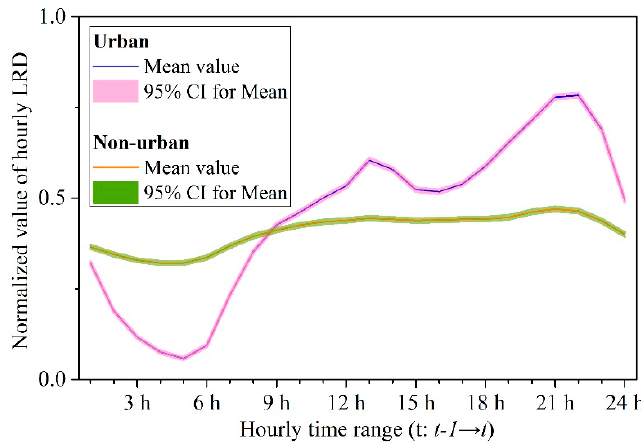
Figure 3. The normalized value of hourly LRD for urban and non-urban samples during the research period. Table 2. The six RS and nine GIS potential features for the random forest classifier. All of the features were calculated based on a 0.01 degree